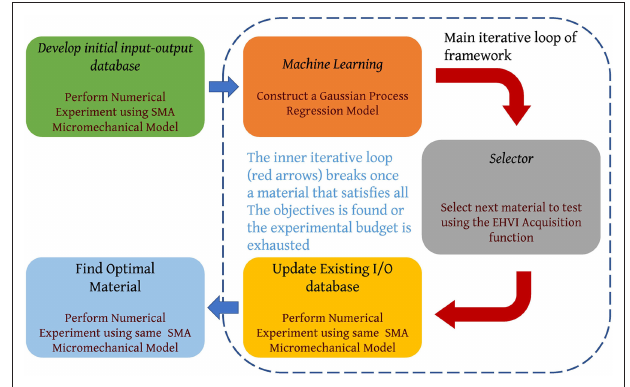
FIGURE 4 | Autonomous closed-loop, multi-objective Bayesian Optimal Experimental Design framework. Adapted from Solomou et al.